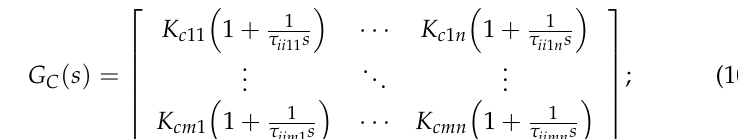
Table 6. Bode plot stability parameters. Stable Marginally Stable Unstable Phase over frequency > gain Phase over frequency = gain Phase over frequency < gain cross over frequency cross over frequency cross over frequency Gain margin > 1 Gain margin = 1 Gain margin < 1 Phase margin = positive Phase margin = 0 Phase margin = negative (Source: Marlin, 2015)